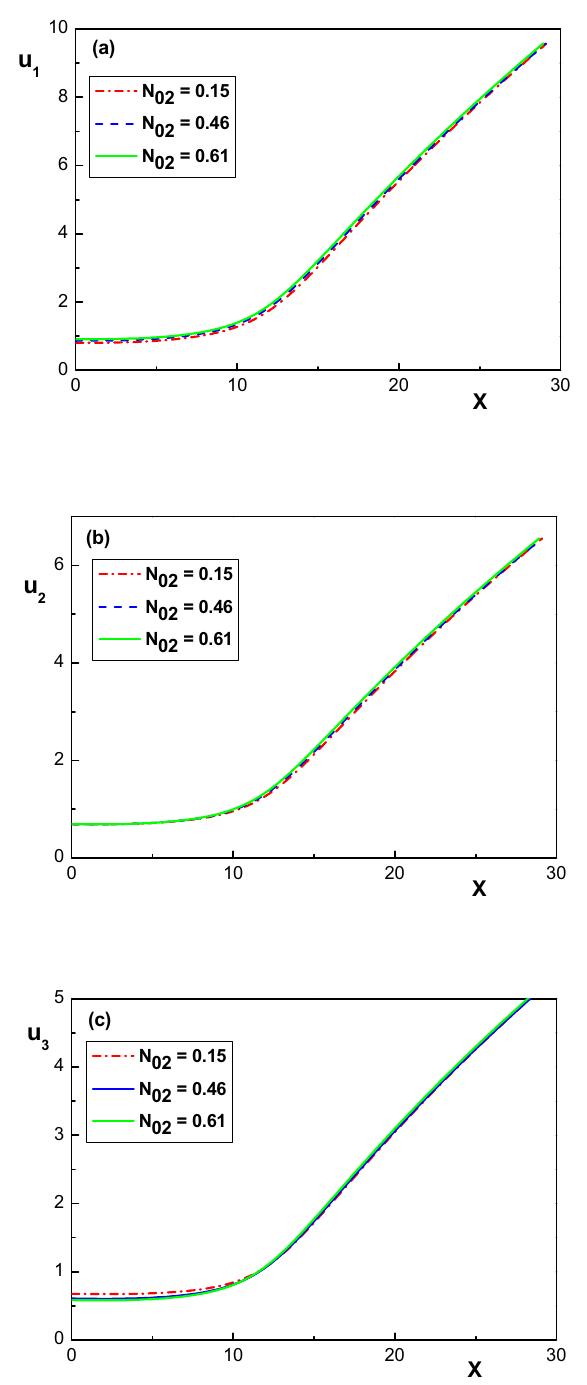
Figure 4. Variation of the normalized ion velocities versus the normalized distance from the sheath edge for different values of N 02 . The other parameters are the same with Fig.